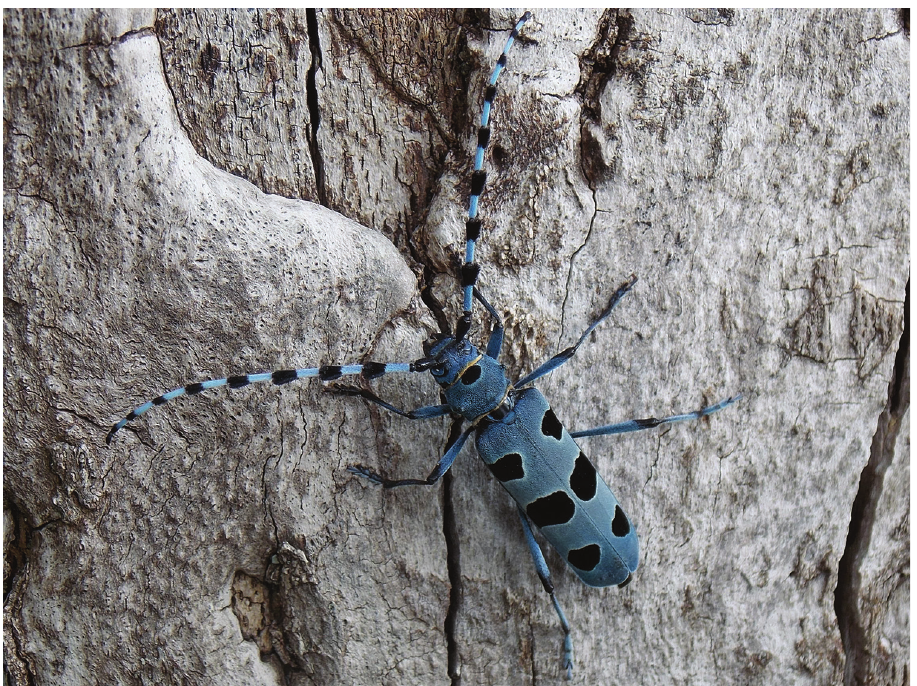
Figure 1. Photograph of an adult specimen of R. alpina (photograph by P. Buonpane, taken in the local- ity Piana delle Sécine, Letino (CE), on date 12.07.2015, record n. 2229, citizen science database of the LIFE MIPP